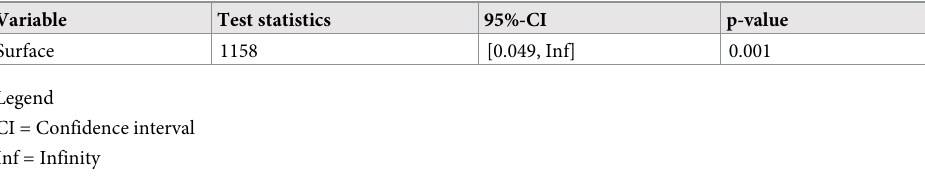
Table 8. Results of the Wilcox test for fragment size grouped by